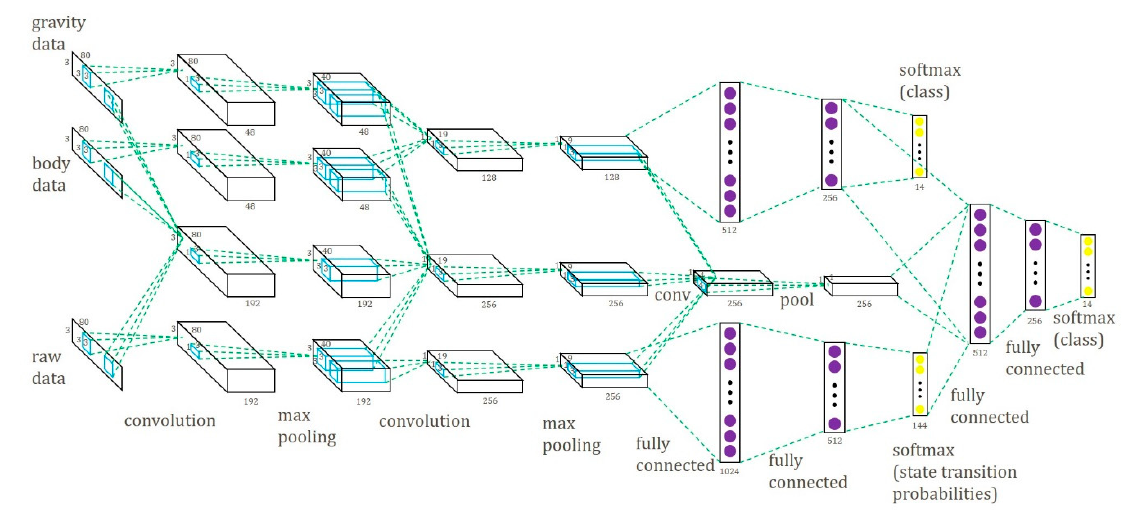
Figure 8. MP-CNN-1(1,2,3) model. Table 1. Accuracy of different numbers of middle layers in the MP-CNN.